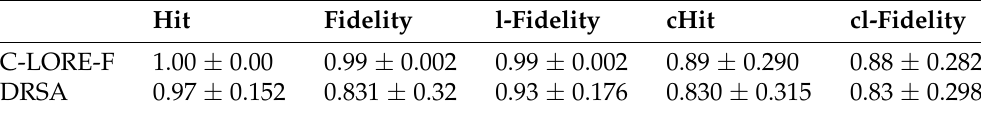
Table 2. Evaluation results of the C-LORE-F and DRSA explanation